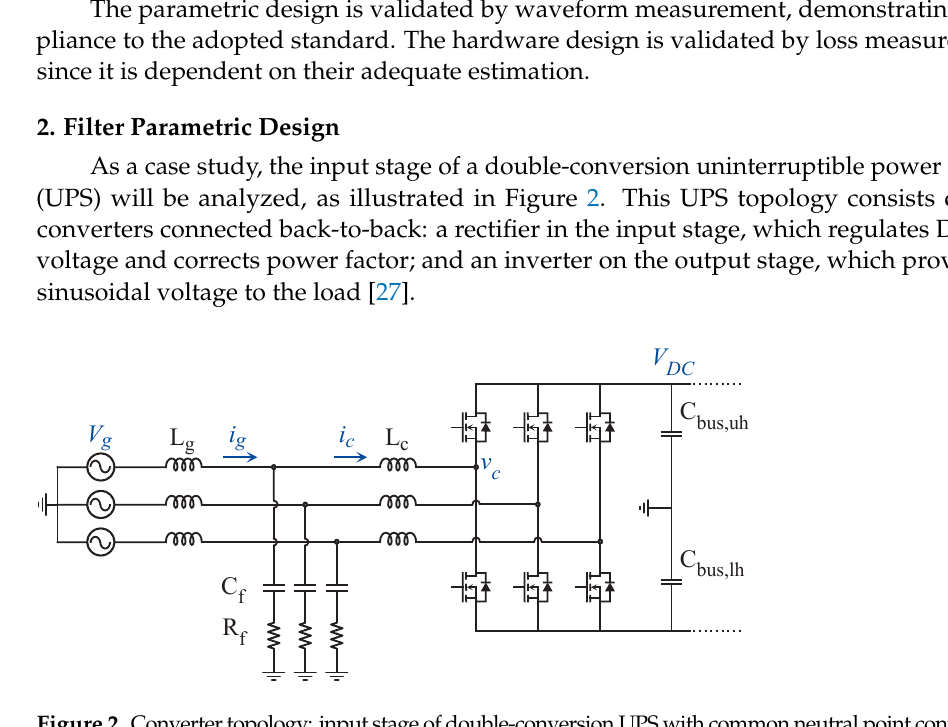
Figure 2. Converter topology: input stageof double-conversion UPS withcommon neutral point